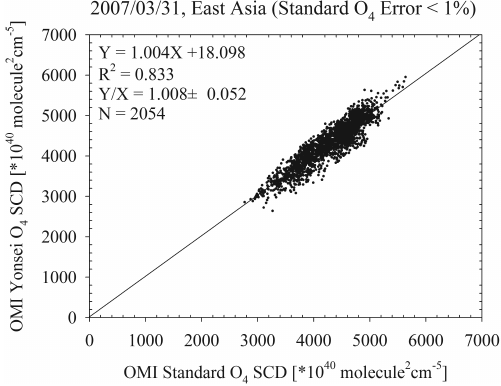
Figure 2. Comparison of O 4 SCD directly retrieved from OMI ra- diance with the OMI standard product on 31 March 2007.